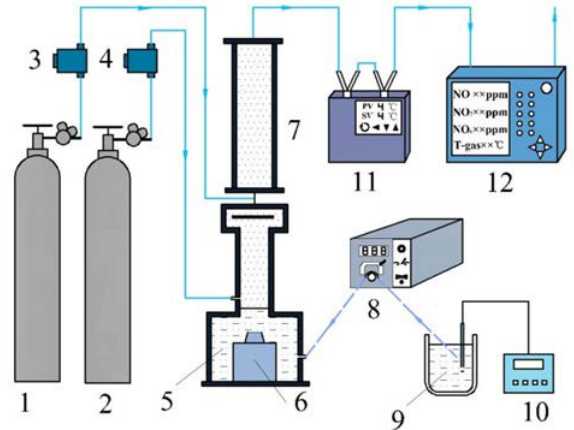
Figure 1. Schematic diagram of the experimental system. (1—N 2 pure gas bottle; 2—NO span gas bottle; 3,4—mass flow controllers (MFC); 5—ultrasonic humidifier; 6—ultrasonic atomizer;